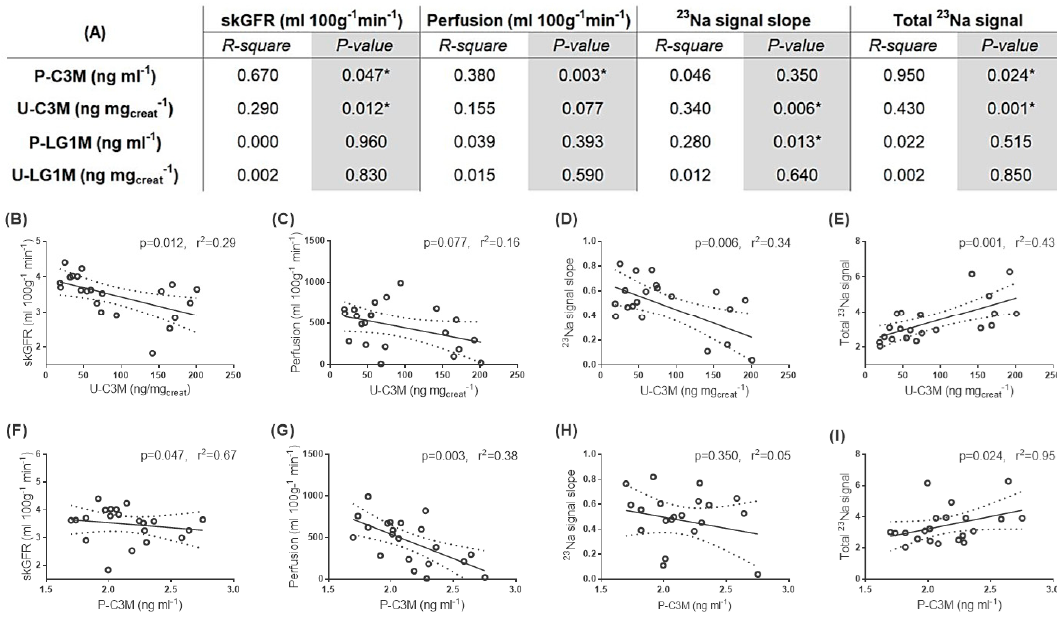
Figure 7. Correlations of extracellular matrix (ECM) markers, type III collagen (C3M), and laminin gamma-1 chain (LG1M) with MRI data: ( A ) a table with Person’s correlations values between noninvasive ECM fibrosis biomarkers (C3M and LG1M) in urine (U) and plasmatic (P) samples and the utilized MRI sequences: single-kidney glomerular filtration rate (skGFR), perfusion, total 23 Na, and 23 Na slope. Linear correlations graphs between ( B ) skGFR and U-C3M, ( C ) perfusion and U-C3M, ( D ) 23 Na signal slope and U-C3M, ( E ) total 23 Na signal and U-C3M, ( F ) skGFR and P-C3M, ( G ) perfusion and P-C3M, ( H ) 23 Na signal slope and U-C3M, and ( I ) total 23 Na signal and P-C3M. * p < 0.05 was considered significant.